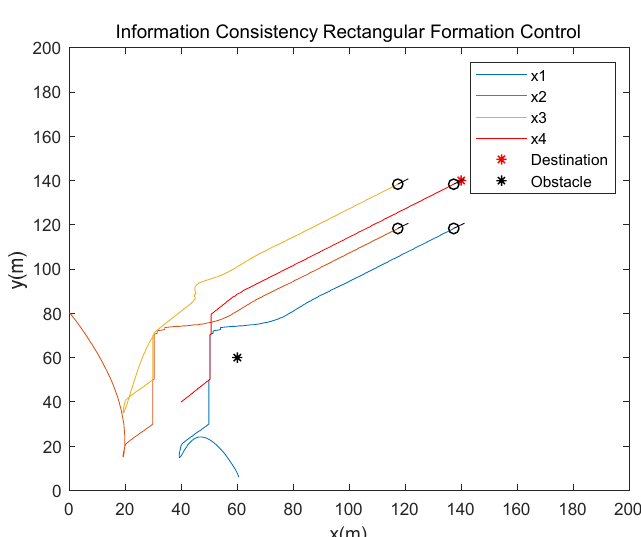
Figure 16. Information consensus rectangular formation control.